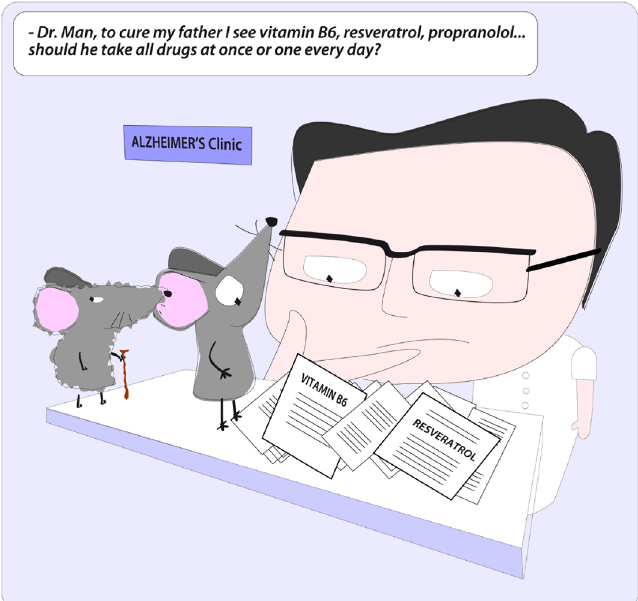
Figure 1. Cartoon depicting the many reported possibilities for “curing” animal models of AD [18]. Copyright retained by Nuria Franco